Question: Generate an informative caption for the figure above.
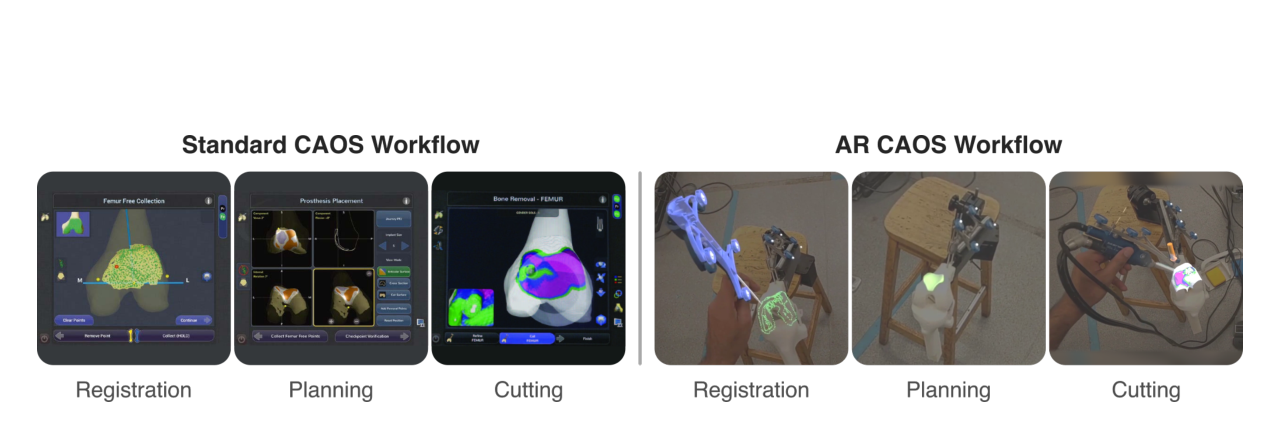
Answer: Comparison of workflows designed for computer and robot-assisted patellofemoral arthroplasty (PFA). Left: screenshots of the standard, monitor- based workflow run by the NAVIO® robot – a commercial CAOS system. Right: Screenshots of our novel AR-centric workflow which reproduces the NAVIO® robot’s entire surgical workflow for PFA in a 3D AR environment through an HMD [8] – an application of the AR-registration method described in this paper.